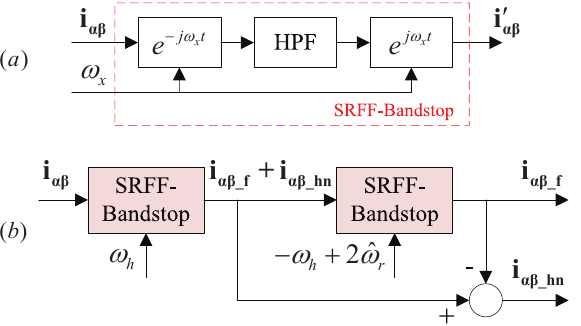
Figure 2. ( a ) Bandstop synchronous reference frame filter (SRFF) and ( b ) subtraction-based current filter used to separate the fundamental and HF negative-sequence current from the overall measured current.